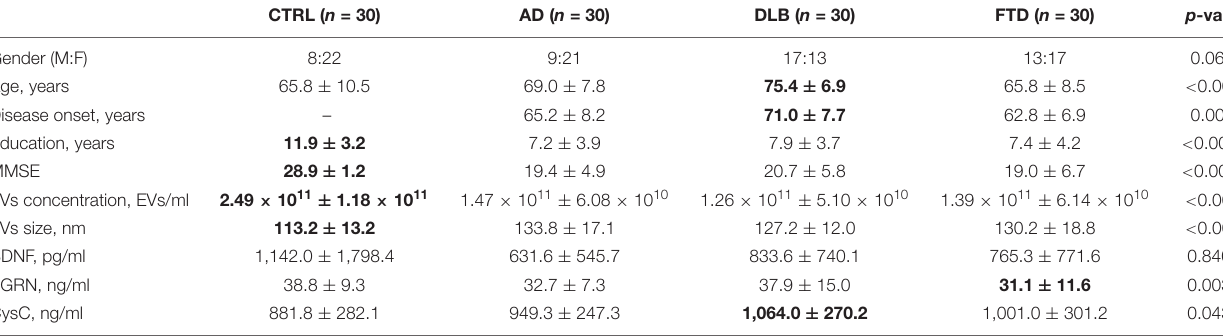
TABLE 1 | Clinical, demographic, and biological variables of patients and